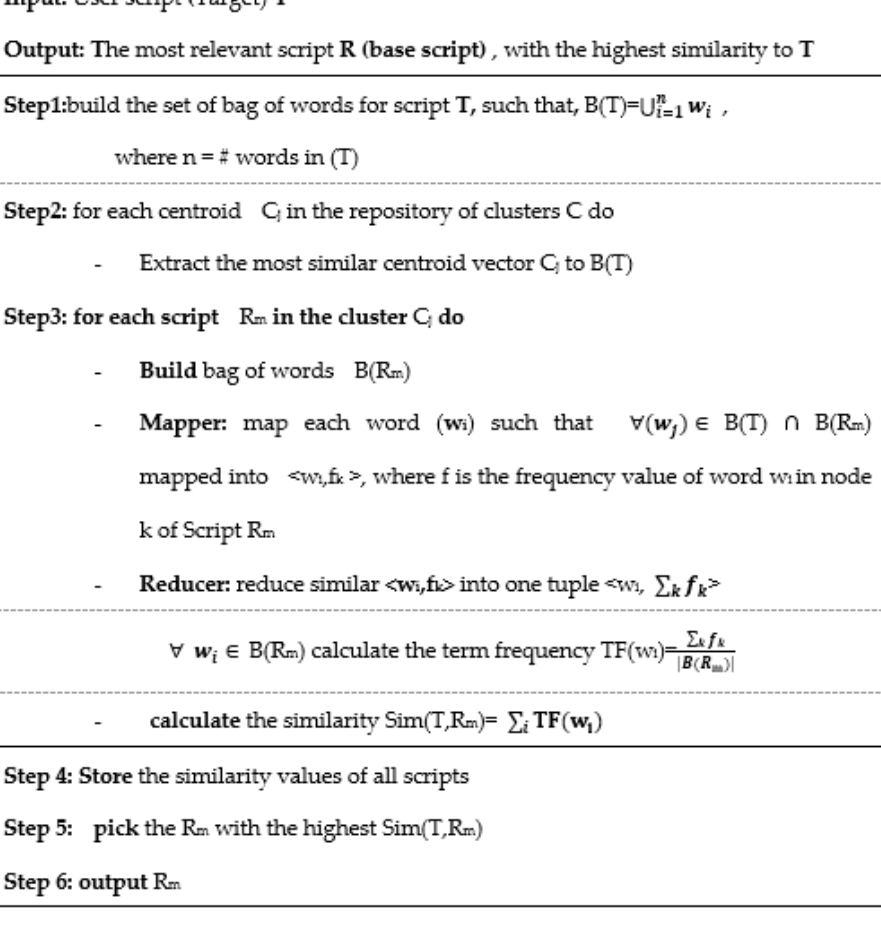
Figure 5. Contextual retrieval algorithm based on H-clustering-map-and-reduce technique.